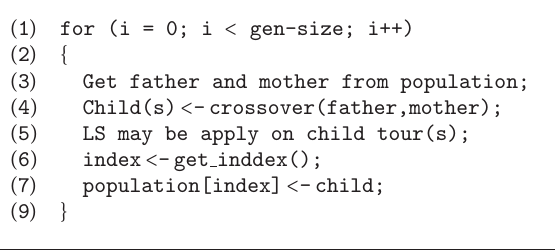
Algorithm 8: Generational GA pseudocodes.